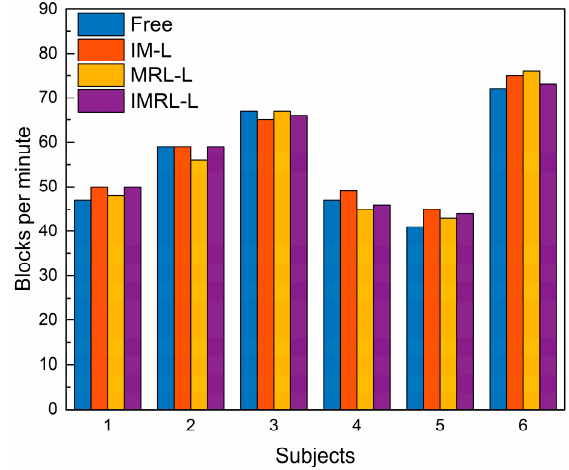
Figure 12. Experimental results of the Box and Block test.